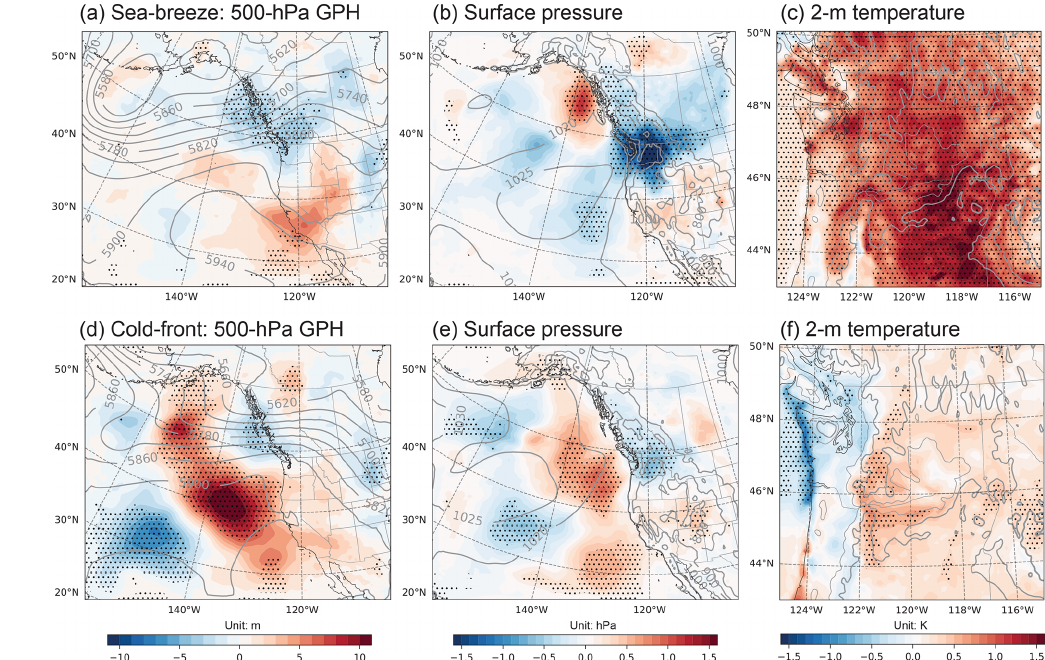
Figure 3. Composite differences in (a) 500hPa GPH, (b) surface pressure, and (c) 2m temperature for the sea-breeze case at forecast hour 29. Panels (d) – (f) are the same as panels (a) – (c) except for the cold-front case and at forecast hour 35. The areas with dots indicate the differences are significant at the level of 0.05. The contours in panels (a) , (b) , (d) , and (e) are the ensemble mean at the initial hour. Gray lines in panels (c) and (f) indicate terrain elevation of 500 (thin) and 1000m (thick).